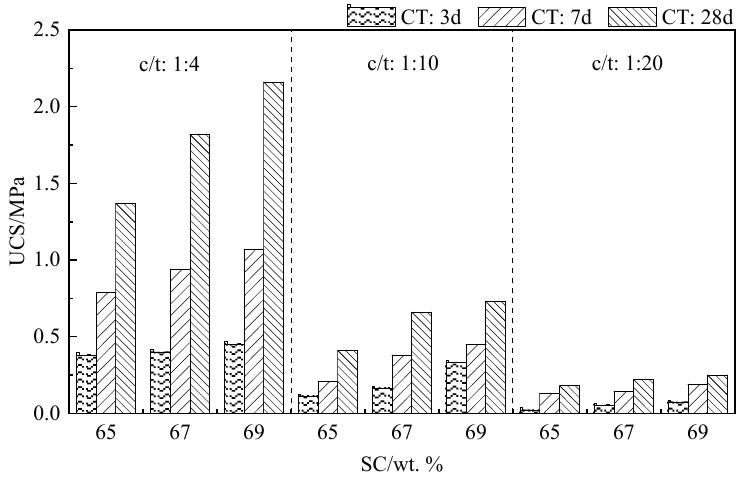
Figure 9. Relations between SC and UCS of CTB mixes.